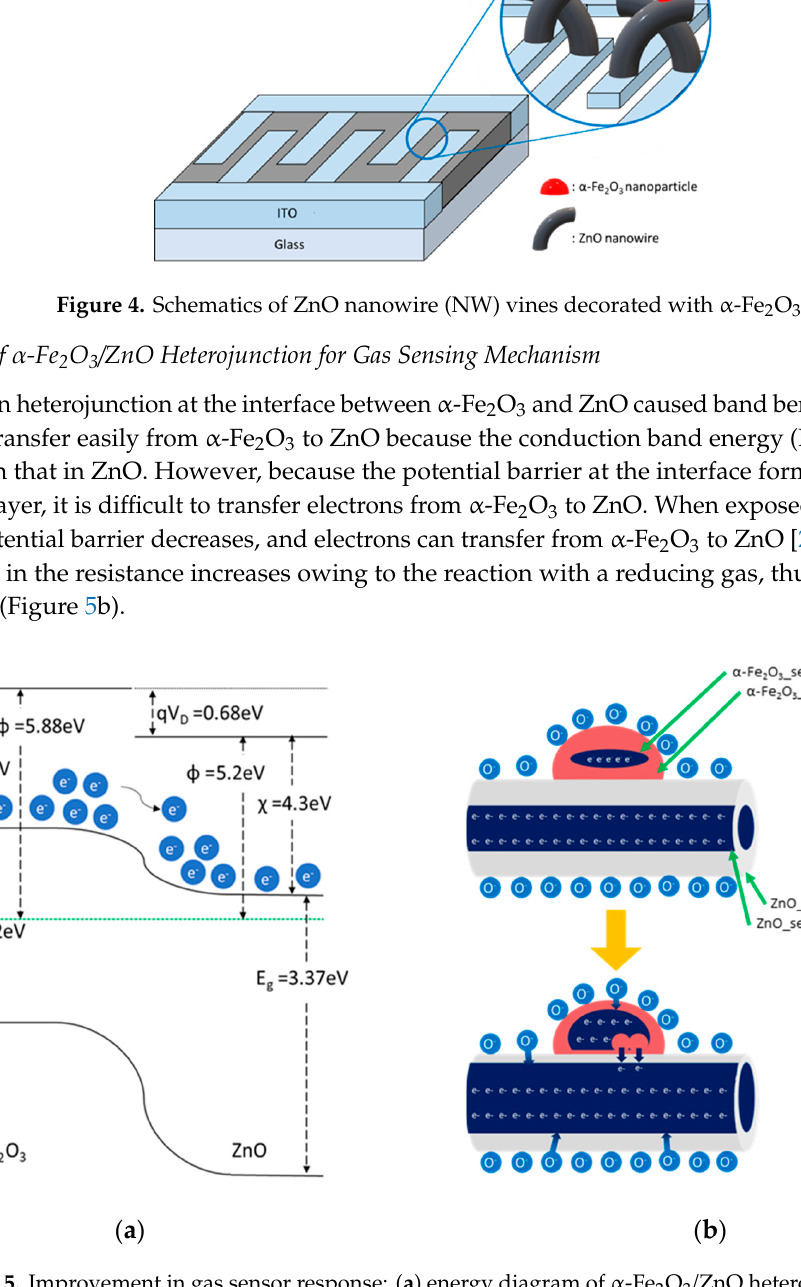
Figure 5. Improvement in gas sensor response: ( a ) energy diagram of α -Fe 2 O 3 /ZnO heterojunction and ( b ) schematics of α -Fe 2 O 3 /ZnO when exposed to a reducing gas.